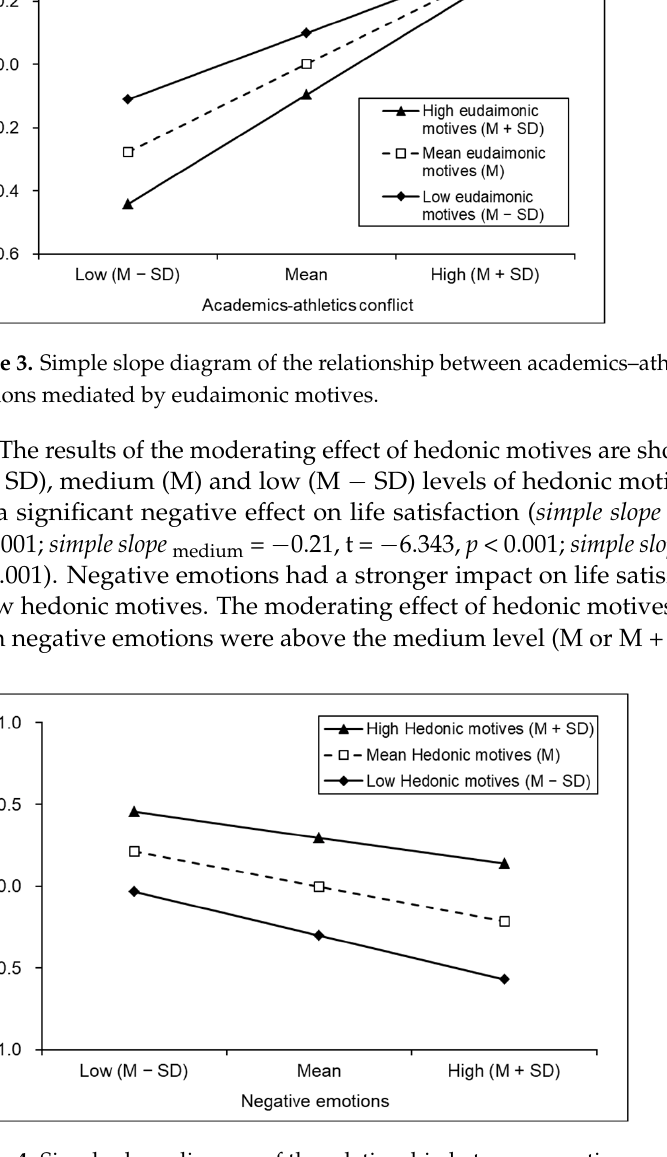
Figure 4. Simple slope diagram of the relationship between negative emotions and Life satisfaction mediated by hedonic